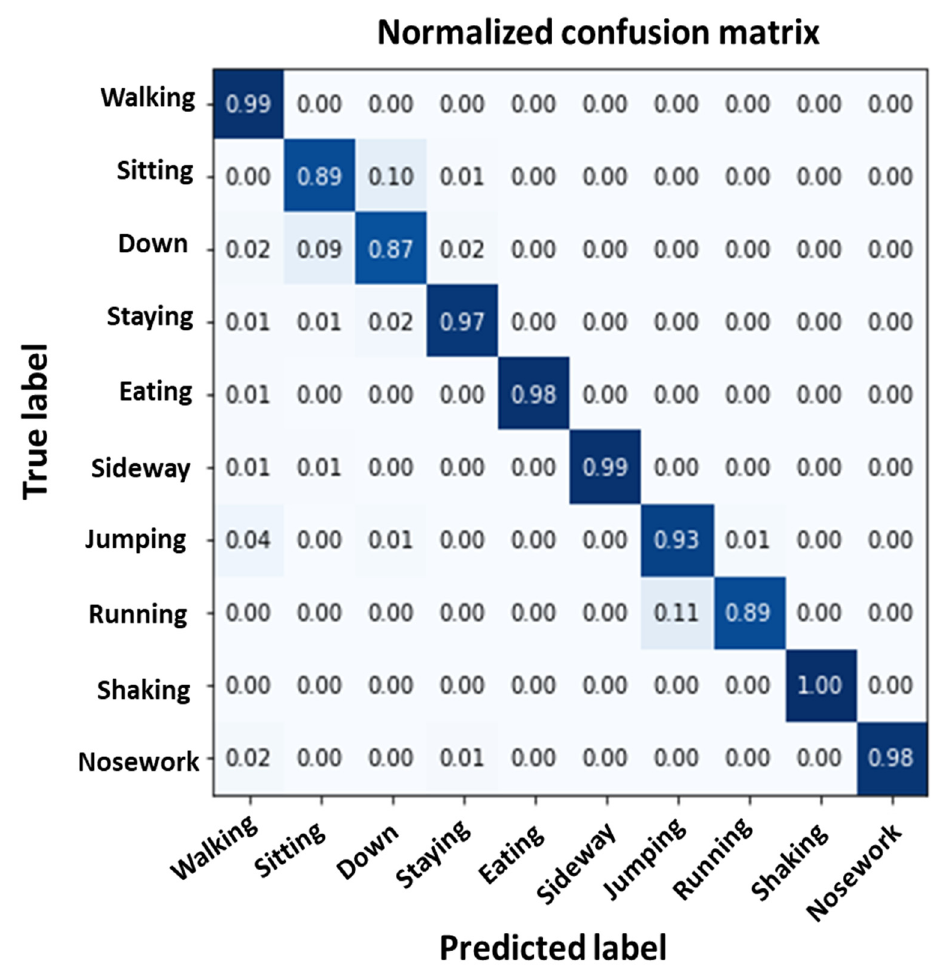
Figure 3. Confusion matrix with normalization.